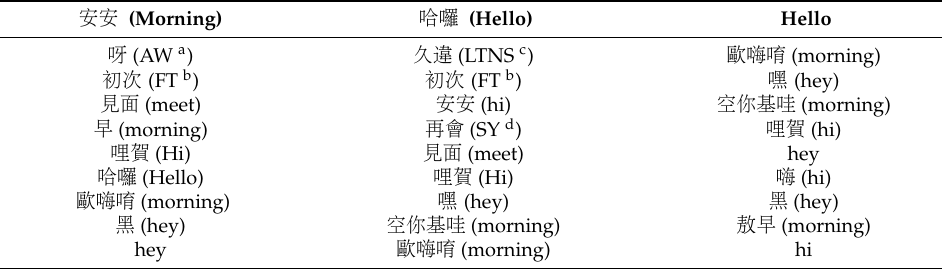
Table 10. Training results of Word2Vec for dialog acts